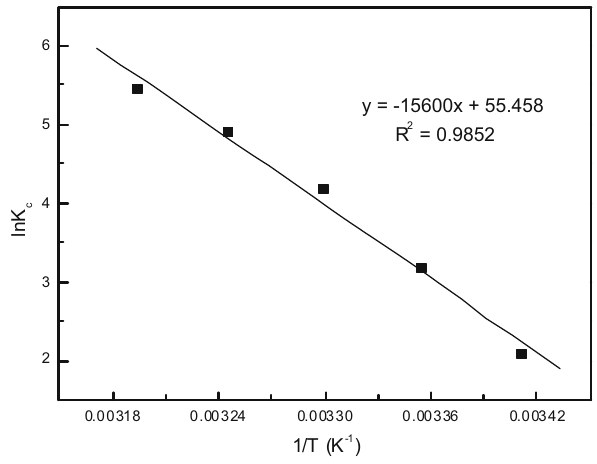
Figure 9: Variation of equilibrium constant ( K c ) as a function of temperature.